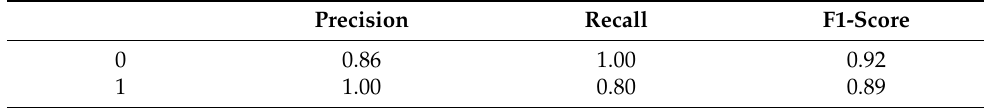
Table 3. Performance Metrics for Testing Data.